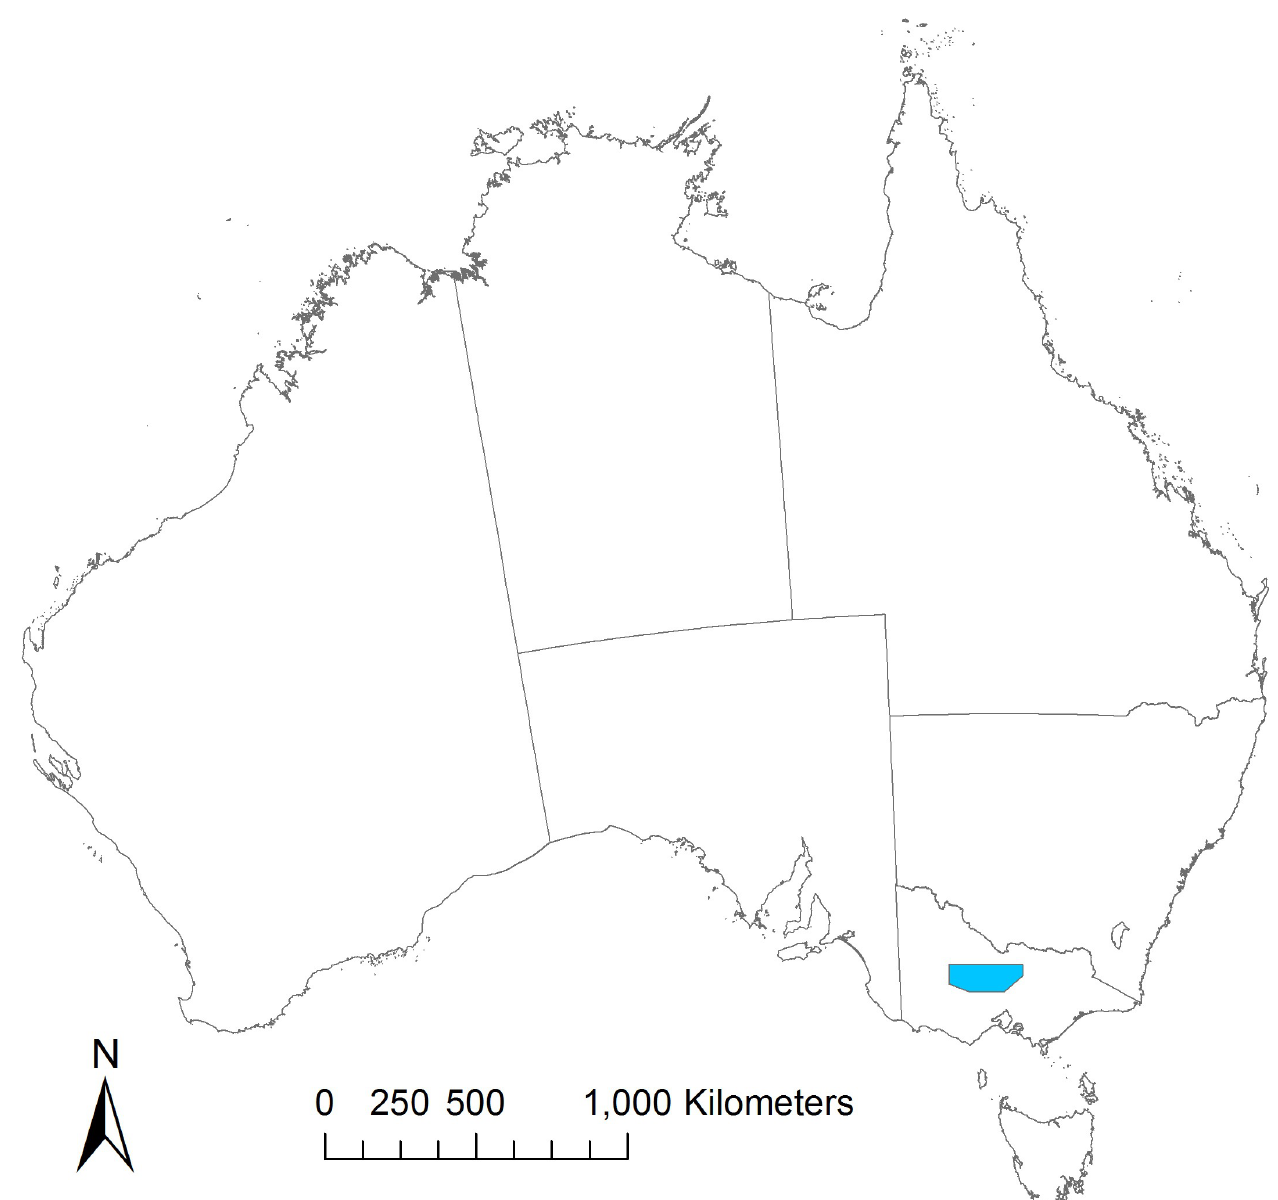
Fig 1. The study area. The area (in blue) is in north-central Victoria,